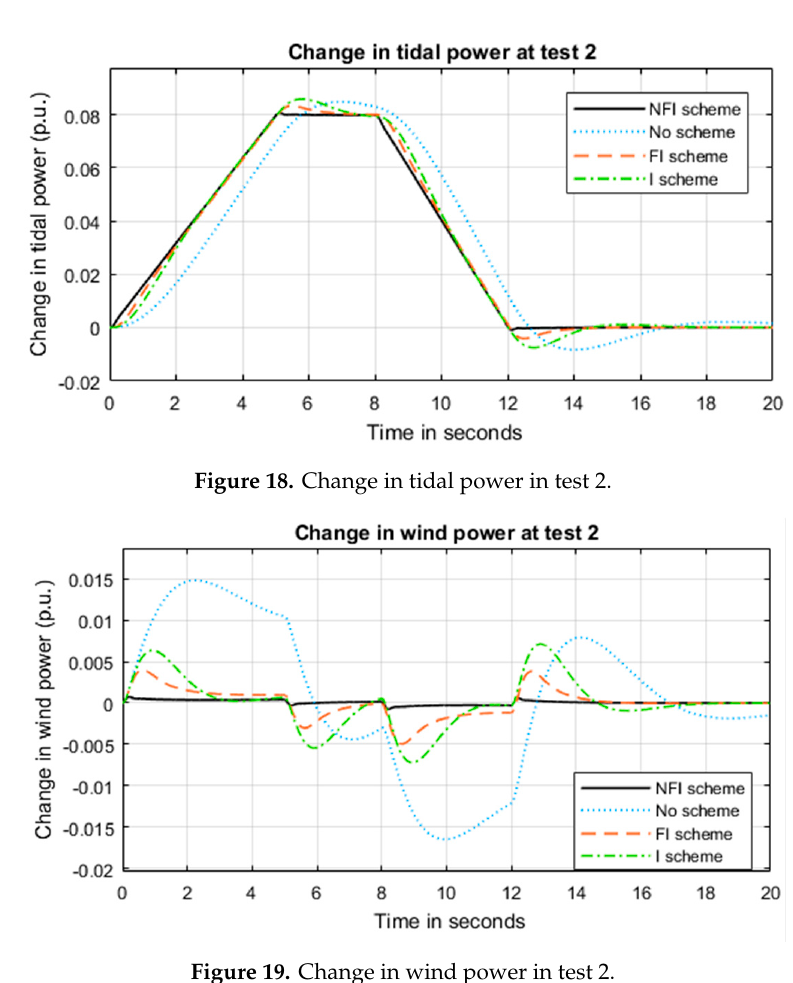
Figure 17. Change in frequency in test 2.